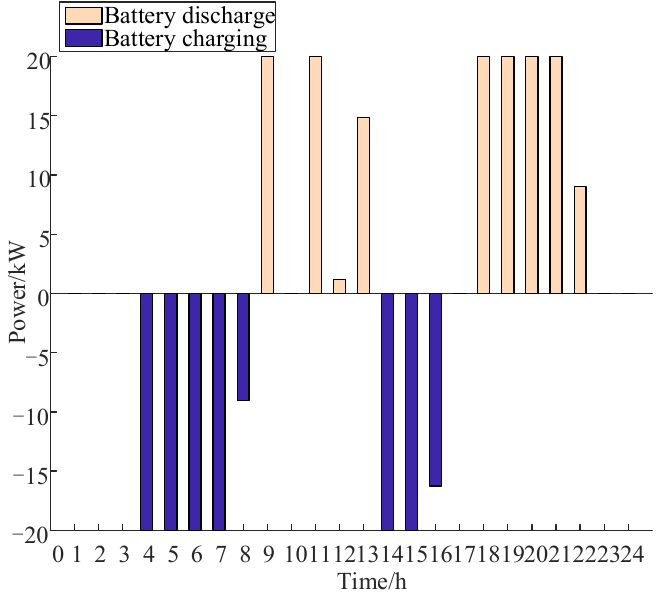
Figure 8. Not counting the battery charge and discharge optimization map without energy storage life attenuation.